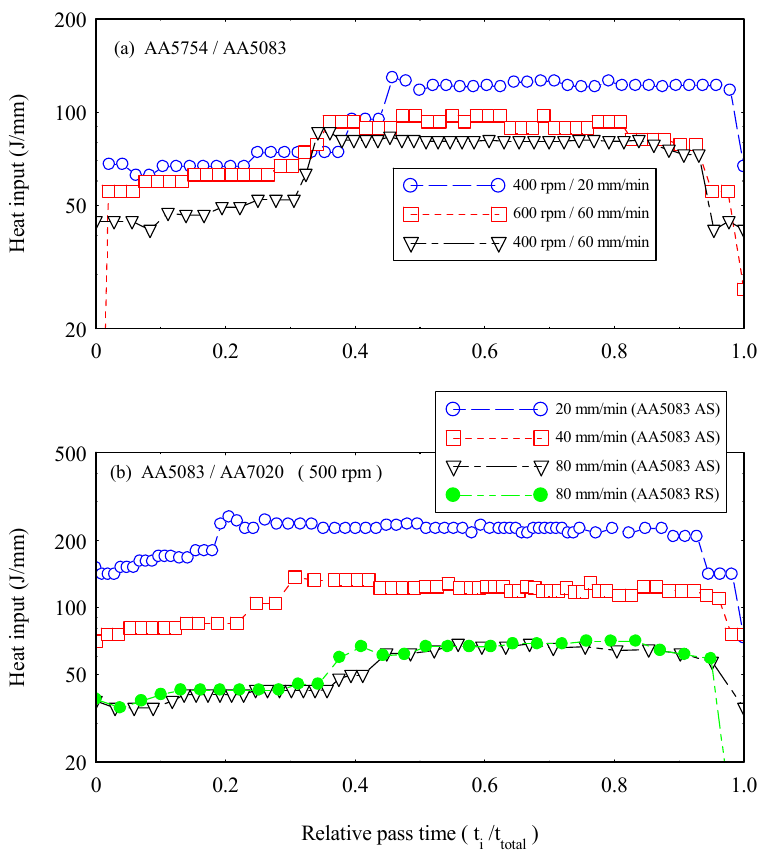
Figure 4. Calculated heat input of friction stir welded joints at different rotation and traverse speeds (i.e., at different ω / v ratios) versus the relative pass time (t i /t total ) for FSW for the joints ( a ) AA5083/AA5754 and ( b ) AA5754/AA7020.